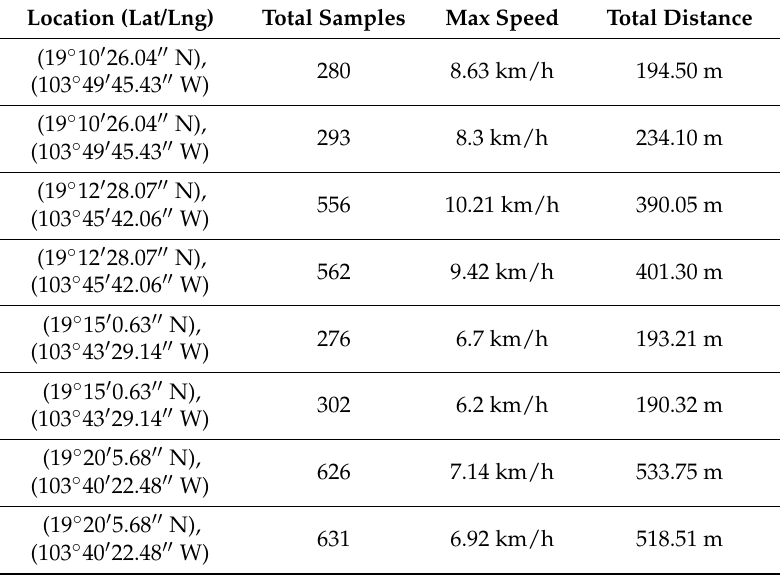
Table 2. Summary of drifter retrieved data.